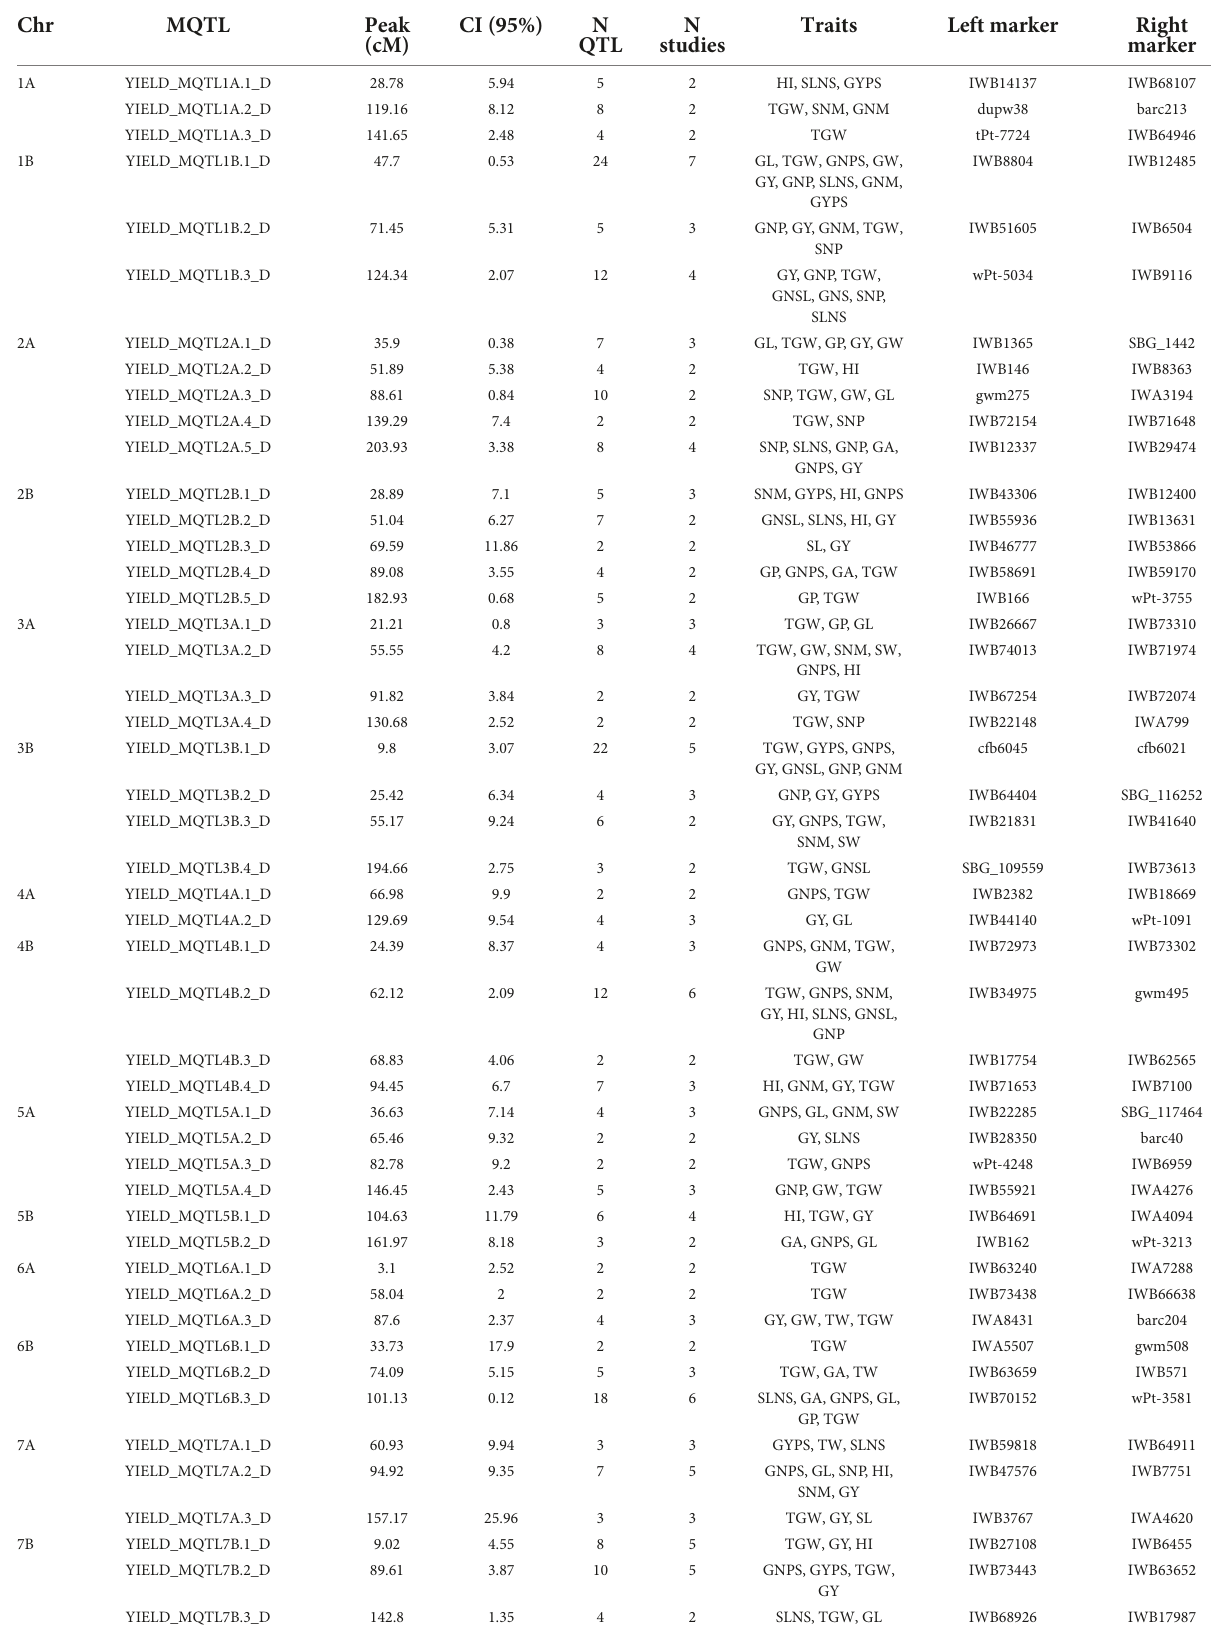
TABLE 4 Characterization of MQTL under rainfed